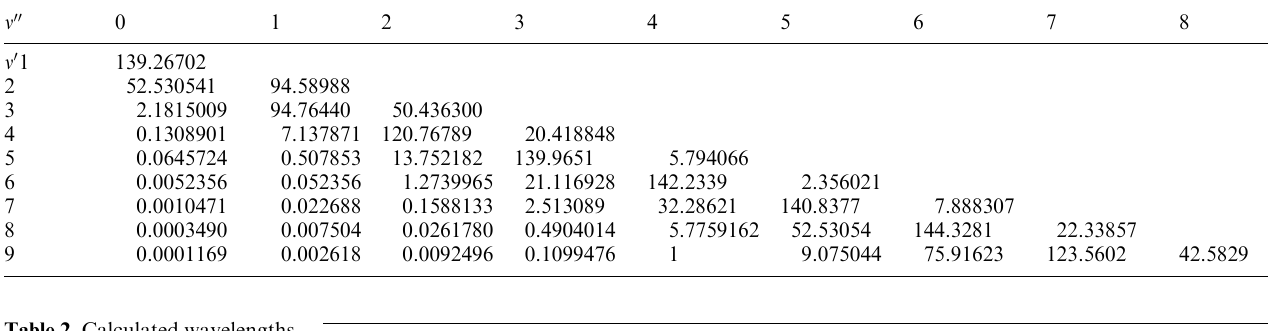
Table 2. Calculated wavelengths (cid:107) (nm) of the OH (cid:3) band origin (Coxon and Foster,